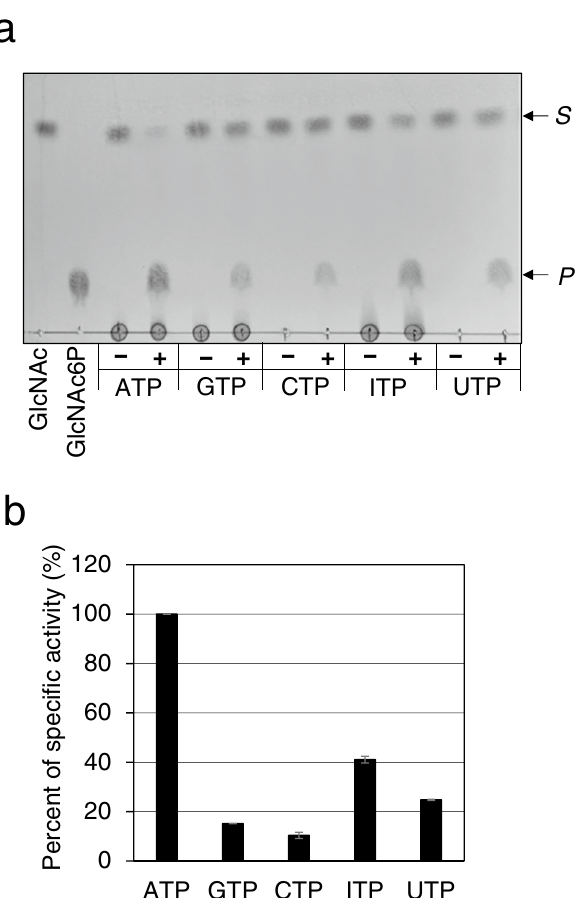
Figure 5. Analysis of the reactivity of Ngk1 to different nucleoside triphosphates. The Ngk1 activity of GlcNAc phosphorylation using either ATP, GTP, CTP, ITP, or UTP as a phosphoryl donor was determined. ( a ) TLC analysis of the reaction (40 min) with (+) or without (−) enzyme. S , sugar substrates; P , products. ( b ) The specific activities were determined by measuring the GlcNAc-6-P concentration using HPLC after the reaction (20 min) with different nucleoside triphosphates. The specific activity of Ngk1 against ATP was set as 100%. Error bars, the standard deviation of two independent